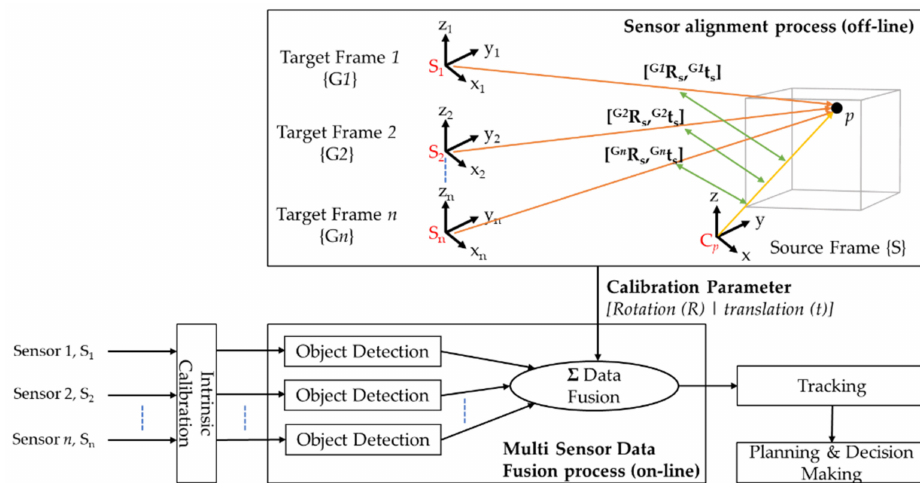
Figure 5. The structure of Multi-Sensor Data Fusion (MSDF) framework for n given sensors. It consists of a sensor alignment process (estimation of calibration parameters—rotation matrix and translations vector) and an object detection process which contains n processing chains, each provides a list of the detected obstacles. Figure redrawn based on depictions in [118], but with the inclusion of an intrinsic calibration